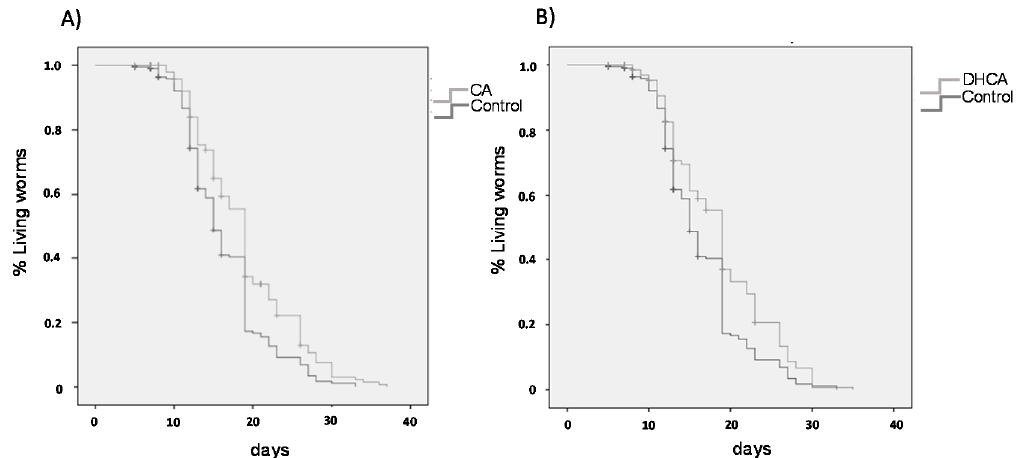
Figure 6. Survival curves of C. elegans cultivated at 20 ◦ C in the absence (control) and presence of ( A ) CA (200 µ M) or ( B ) DHCA (300 µ M). Table 1. Influence of CA (200 μ M) and DHCA (300 μ M) on mean and maximum lifespan of C. elegans under normal growing conditions at 20 °C. The results represent the mean ± SEM ( n = 3). Mean Lifespan p vs. Control Maximum Lifespan* p vs. Control Treatments (days) (Log-Rank) (days) (ANOVA) Control 16.4 ± 0.39 26.9 ± 0.63 CA (200 μ M) 19.0 ± 0.47 0.001 30.0 ± 0.72 0.009 DHCA (300 μ M) 18.7 ± 0.46 0.001 28.9 ± 0.45 0.014 * Average maximum lifespan of 10% of the longest-lived population.